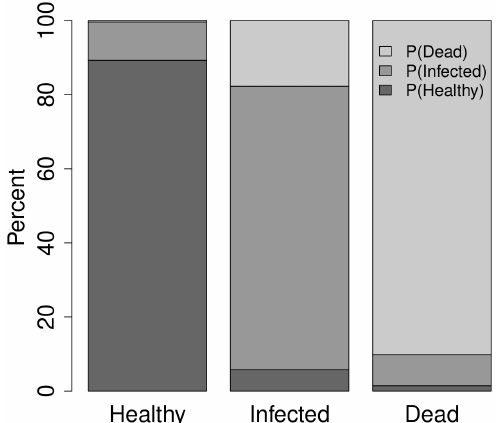
Figure 8. Mean observation probabilities for infection status based on latent infection status. Note that the x -axis is the latent (true) value, while the y -axis is the observed value. For example, 20% of trees that were infected were observed to be dead